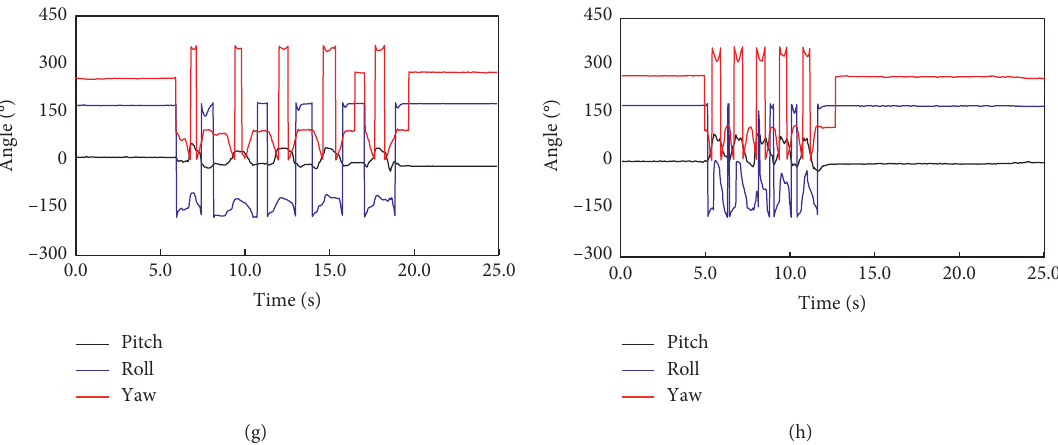
Figure 7: (a) The acceleration value obtained by the normal movement of the left arm, as shown in Figure 6(a). (b) The acceleration value obtained by the left arm in the unstable state of the arm shaking, as shown in Figure 6(a). (c) The angle value of the normal movement of the left arm. (d) The angle value of the normal movement of the right arm. (e) The angle value obtained under the unstable state of the left arm shaking. (f) The angle value obtained under the unstable state of the right arm shaking. (g) Change in angle for five normal arm movements. (h) Change in angle for five normal arm